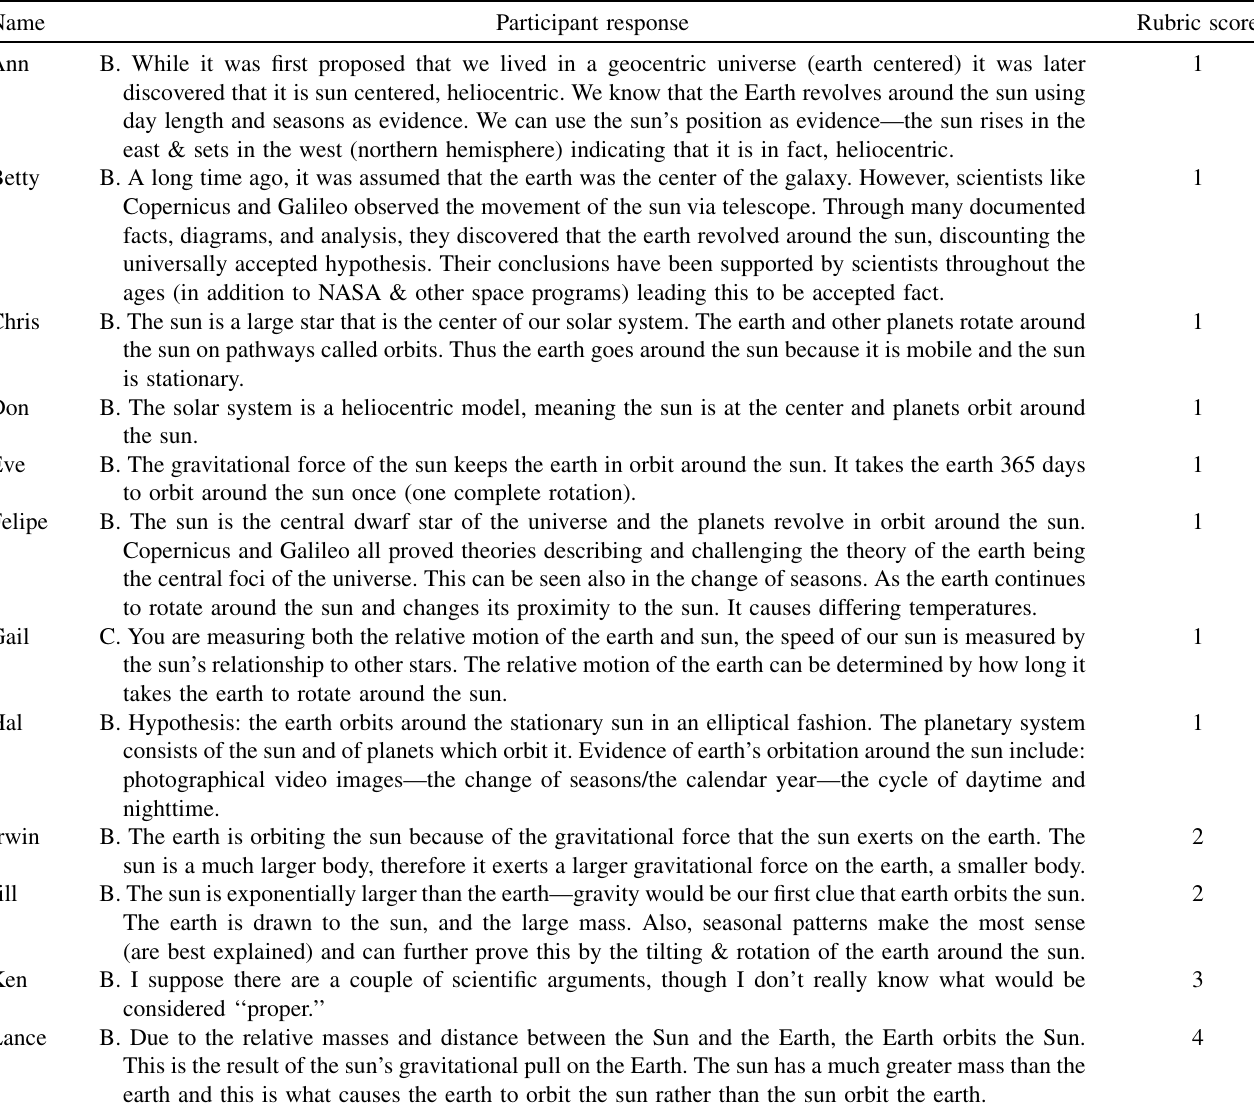
TABLE III. Sample full verbatim pretest responses to ‘‘proper and complete scientific argument’’ question in Fig. 1. A, B, C, and D refer to multiple-choice response